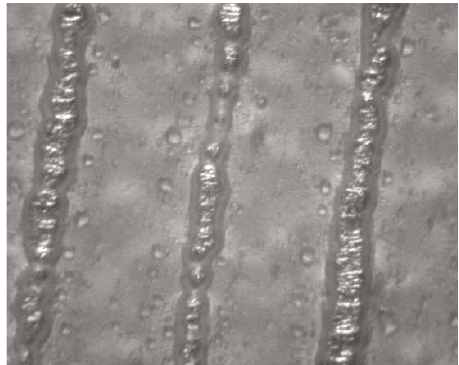
Fig. 4. Strokes of the scale made by the extensive power of the laser cutter